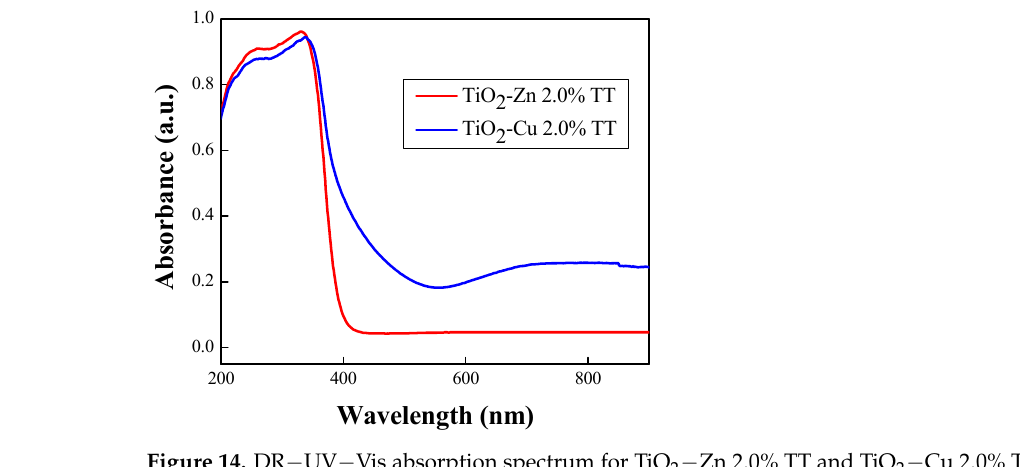
Figure 14. DR − UV − Vis absorption spectrum for TiO 2 − Zn 2.0% TT and TiO 2 − Cu 2.0% TT samples. The photocatalytic degradation of methyl orange solution in the presence of undoped and doped TiO 2 was carried out under UV and visible light irradiation. The results presented in Figure 15 showed that the introduction of a doping element in titanium dioxide leads to a higher photocatalytic activity.